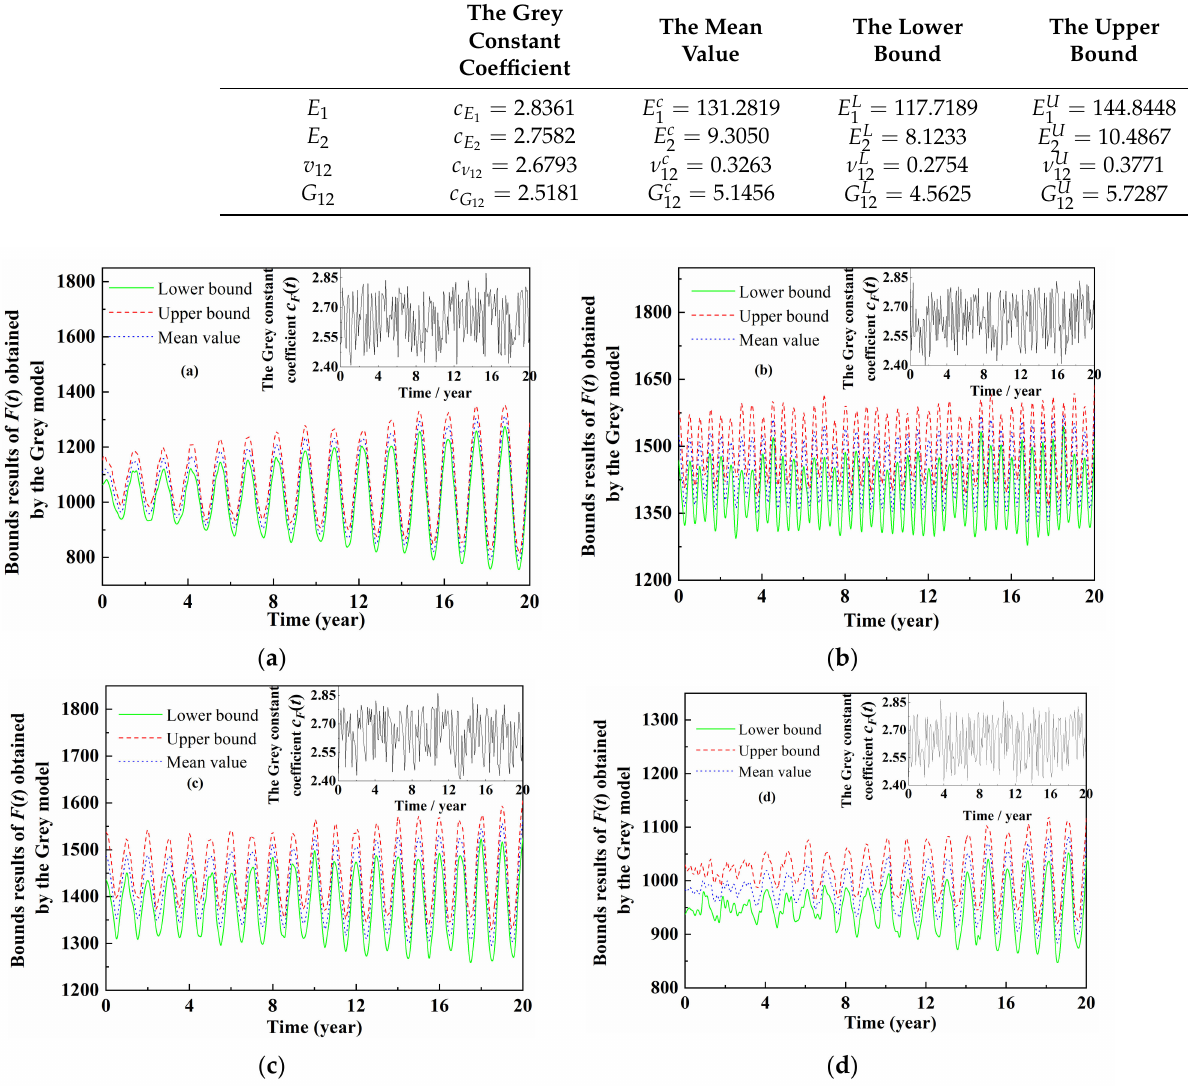
Table 2. Quantification results for static uncertainty characteristics E 1 E 2 , ν 12 , and G 12 .